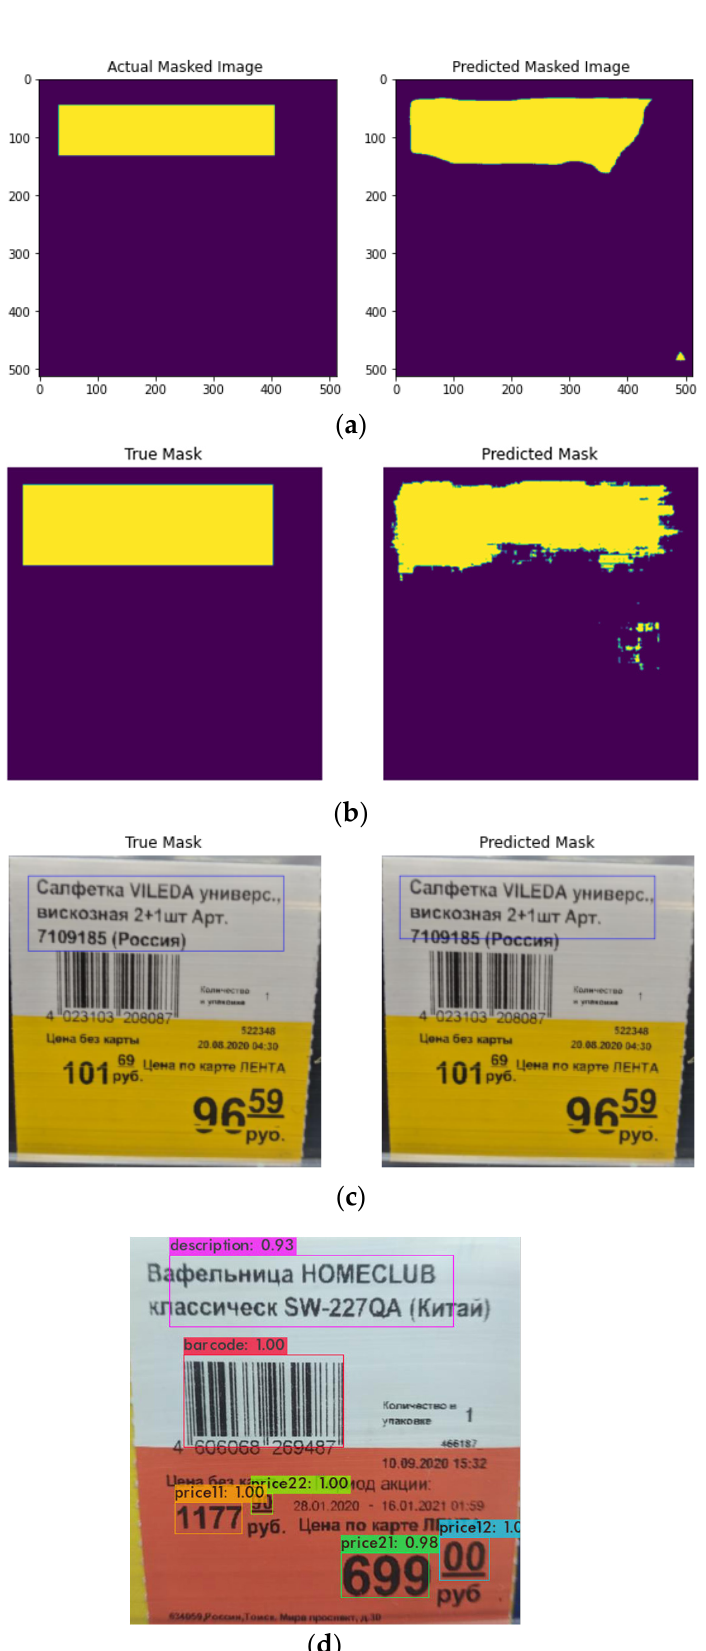
Figure 9. Change in the loss-function: ( a ) UNet, MobileNetV2, VGG16; ( b ) YOLOv4-tiny. The results for the trained networks are shown in Figure 10.